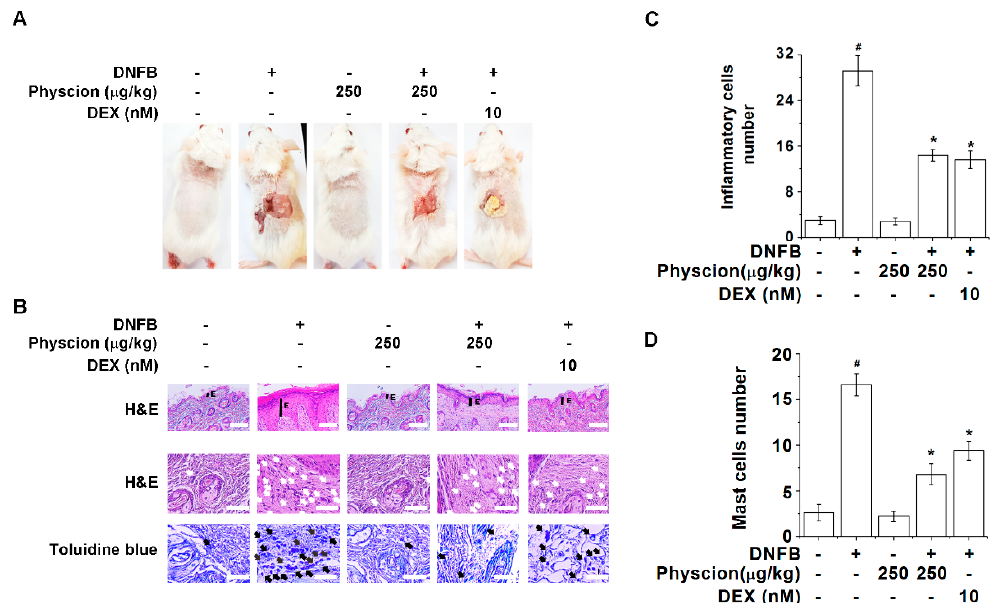
Figure 5. Physcion relieves pathological changes of AD-like lesional skin. ( A ) Representative dorsal skin photographs are shown. ( B, top ) Histological features of lesional skin tissues are shown. The sections from lesional skin were stained with H&E staining. E, epidermis. Magnification 200 × , scale bar = 75 µ m. ( B, middle ) Arrows indicate inflammatory cells. Magnification 400 × , scale bar = 37 µ m. ( B, bottom ) The sections from lesional skin were stained with toluidine blue staining. Arrows indicate mast cells. Magnification 400 × , scale bar = 37 µ m. The numbers of ( C ) inflammatory cells and ( D ) mast cells were quantified. # p < 0.05 vs. a vehicle group. * p < 0.05 vs. a DNFB control group. (n = 5).